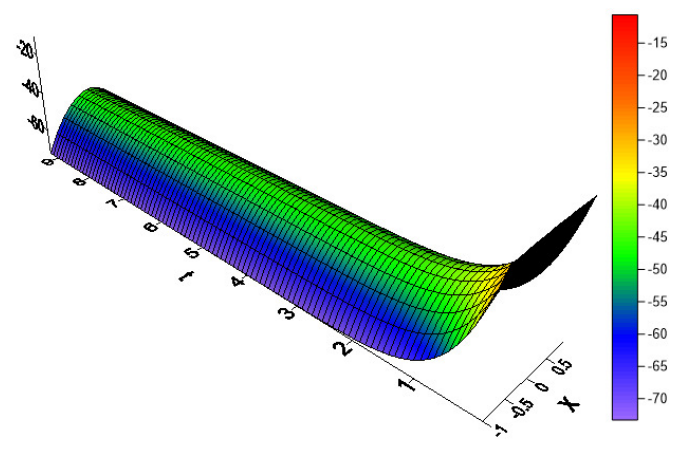
Figure 5. Evolution towards the stationary solution taking as solar constant Q = 197. The stationary temperatures are negative for all latitudes.